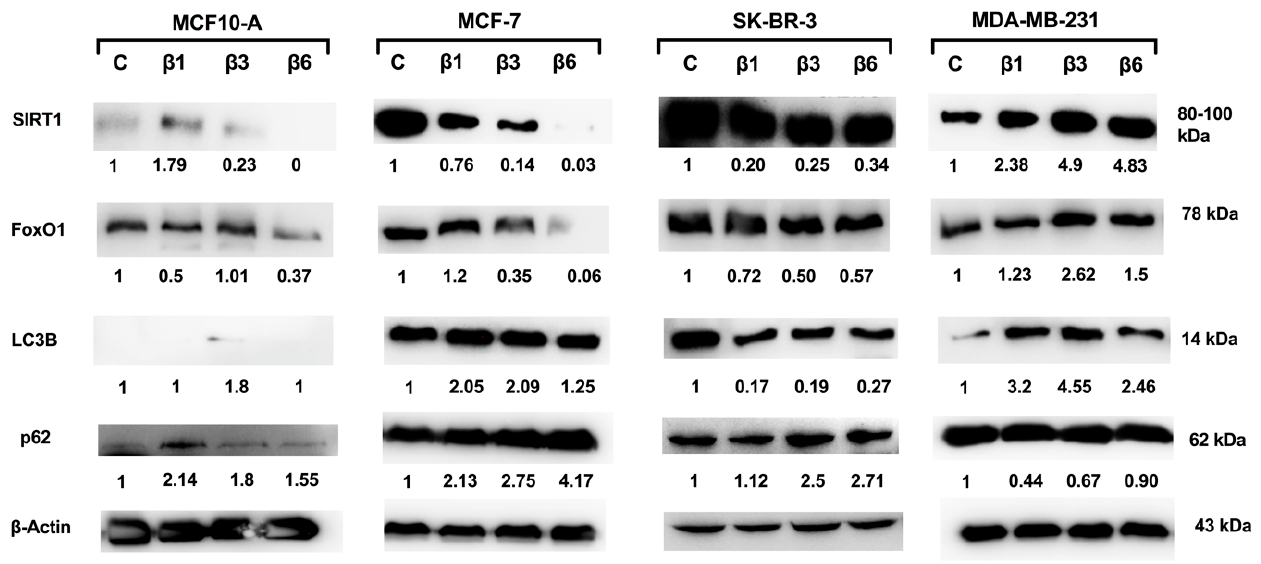
Figure 5. Western blot analysis of SIRT1, FoxO1, LC3B, and p62 proteins. Β -actin was used as a control . Cells were treated with β 1-conglutin (2.5 ng/µL), β 3-conglutin (5 ng/µL), or β 6-conglutin (10 ng/µL) for 24 h in MCF10-A, MCF-7, SK-BR-3, and MDA-MB-321.